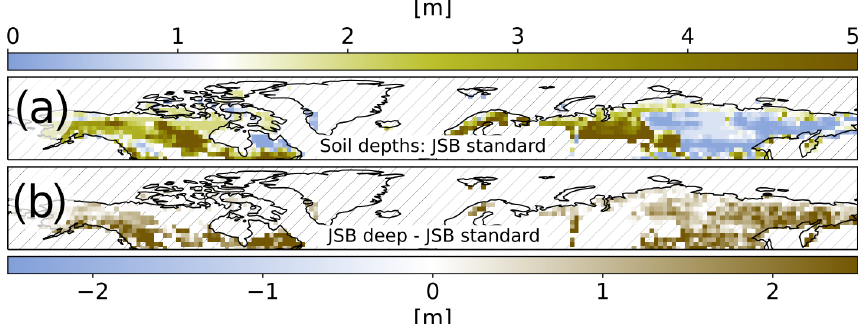
Figure 5. Soil depths. (a) Soil depths used in the JSBACH (JSB) standard setup. (b) Difference in soil depths between the setup with deeper soils (Carvalhais et al., 2014; Schneider von Deimling et al., 2018) and the standard